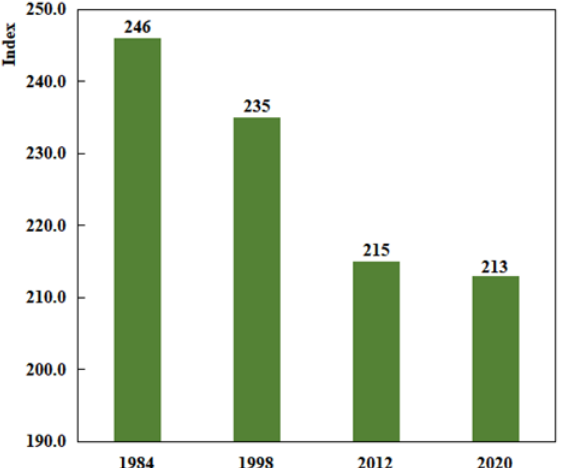
Figure 4. Comprehensive quantified index of land-use degree in the study area from 1984 to 2020.